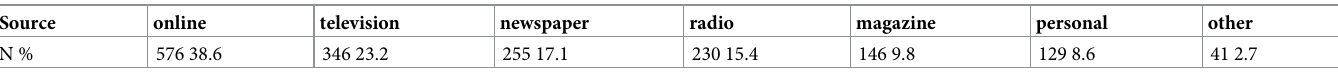
Table 2. Binned answers of the free-form response to the question ‘where did you hear about the ‘Mu¨ckenatlas’?’. Source